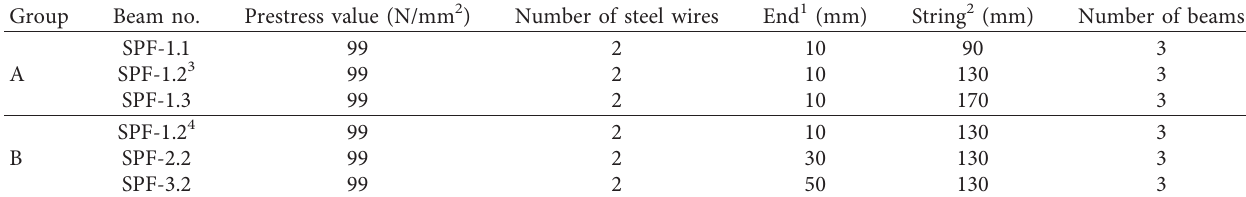
Table 1: Basic parameters for test components.